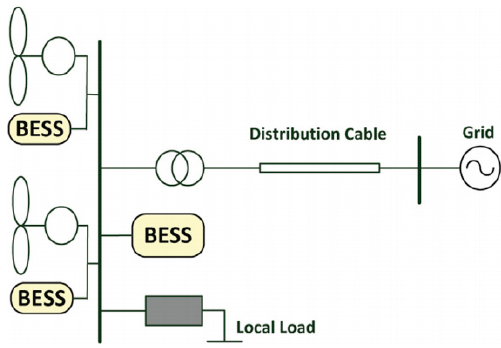
Figure 8. Semi-distributed BESS configuration. Reprint with permission [73]; Copyright 2014, Elsevier.